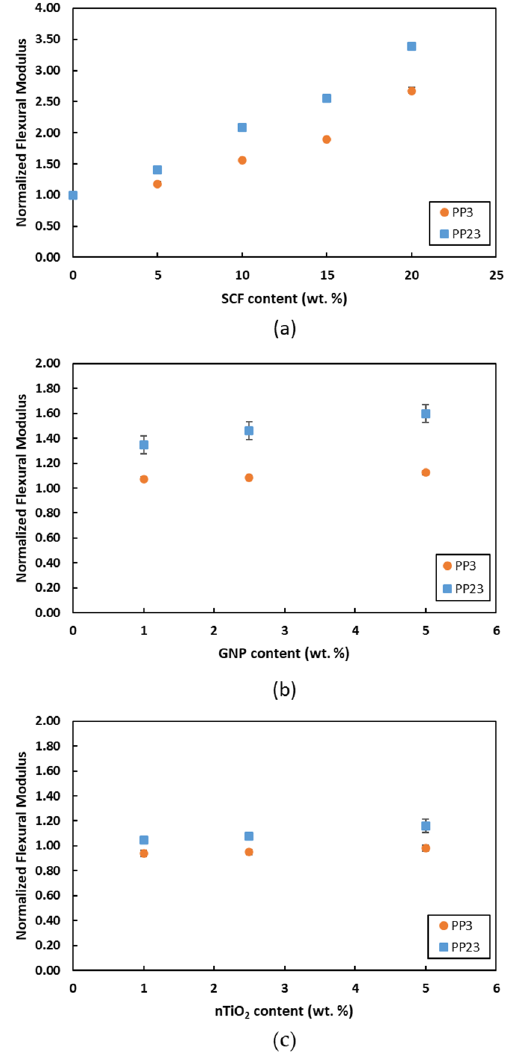
Figure 13. Normalized flexural modulus of ( a ) PP/SCF, ( b ) PP/GNP, and ( c ) PP/nTiO 2 composites.